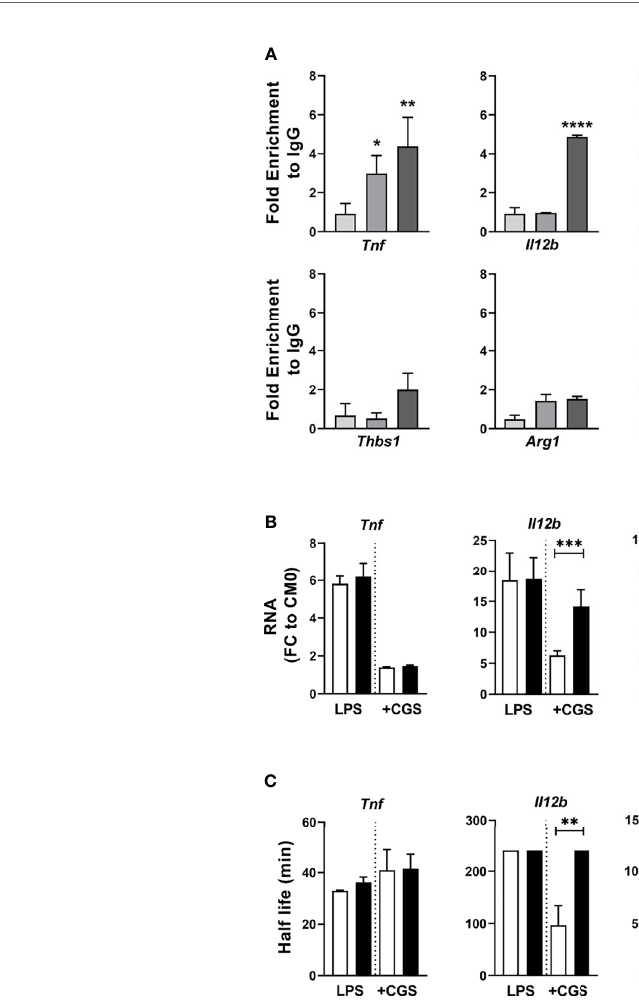
FIGURE 7 | Adenosines promote the binding of AUF1 upon selective transcripts leading to their differential control. (A) qRT-PCR detection of selected mRNAs tested to IP with anti-AUF1 in control BMDMs activated with LPS or LPS+CGS compared to untreated (M0). Enrichment of each mRNA in AUF1-IP samples compared with its abundance in IgG-IPs and normalized to mRNA expression levels. Enrichments above two-fold were considered signi fi cant. (B) Expression levels of mRNAs bound by AUF1 were measured in extracts from BMDMs activated with LPS or LPS+CGS. (C) The half-lives ( t 1/2 ) of Tnf, Il-12b and Vegf mRNA were quanti fi ed by measuring the time required for reducing transcript levels to 50% of their original abundance after adding actinomycin as in Figure S7B . Graphs depict mean values ± SD. Note that half-lives in Il-12b mRNAs under LPS or under LPS+CGS in the mutants lack variation since they exceed monitoring times and as such were assigned a common maximal value. In all cases, data were analyzed by two tailed, unpaired Student ’ s t test. *p ≤ 0.05, **p ≤ 0.01 ***p ≤ 0.001, ****p ≤